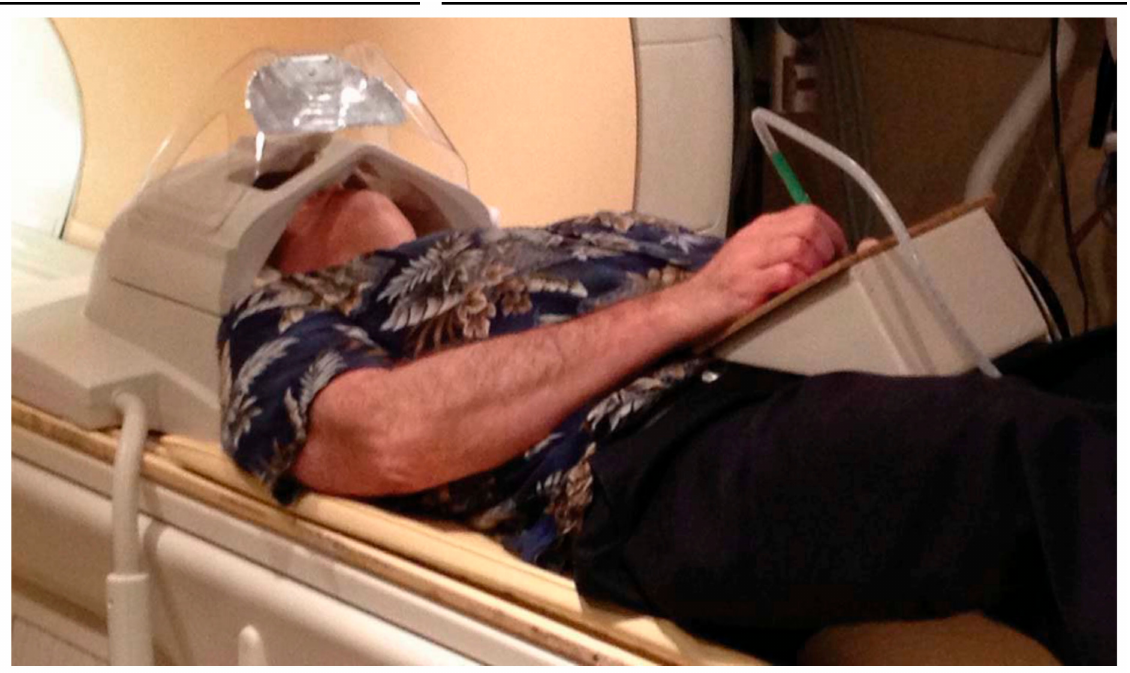
Figure 4. The fMRI-compatible Reitz tablet setup. The optical fibres are routed from the stylus tip to a light-tight box outside the magnet room. A mirror was mounted on the head coil to enable real-time visual feedback of task stimuli and response via video projection (not shown). Taken from [25]. Copyright © 2013 Reitz et